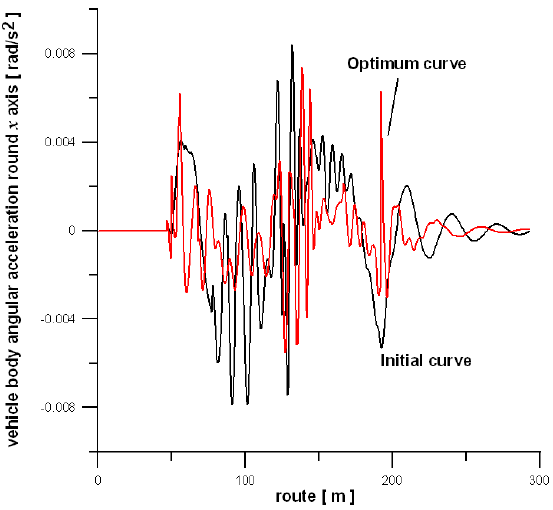
Figure 8. Dynamical characteristics-vehicle body angular accelerations around x -axis.